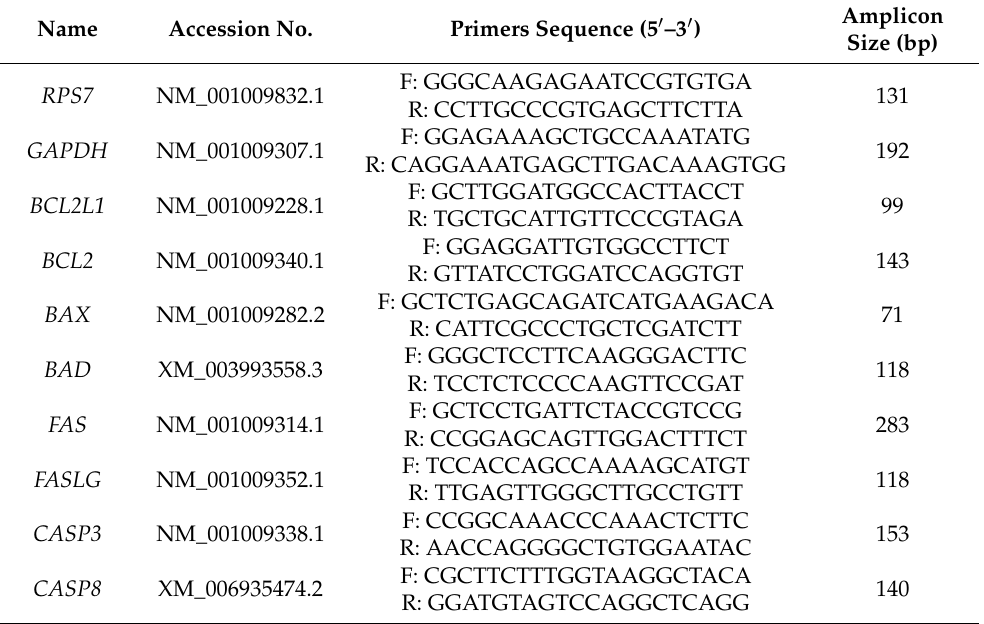
Table 1. Primer sequence for quantitative real-time polymerase chain reaction amplification of mRNA from feline